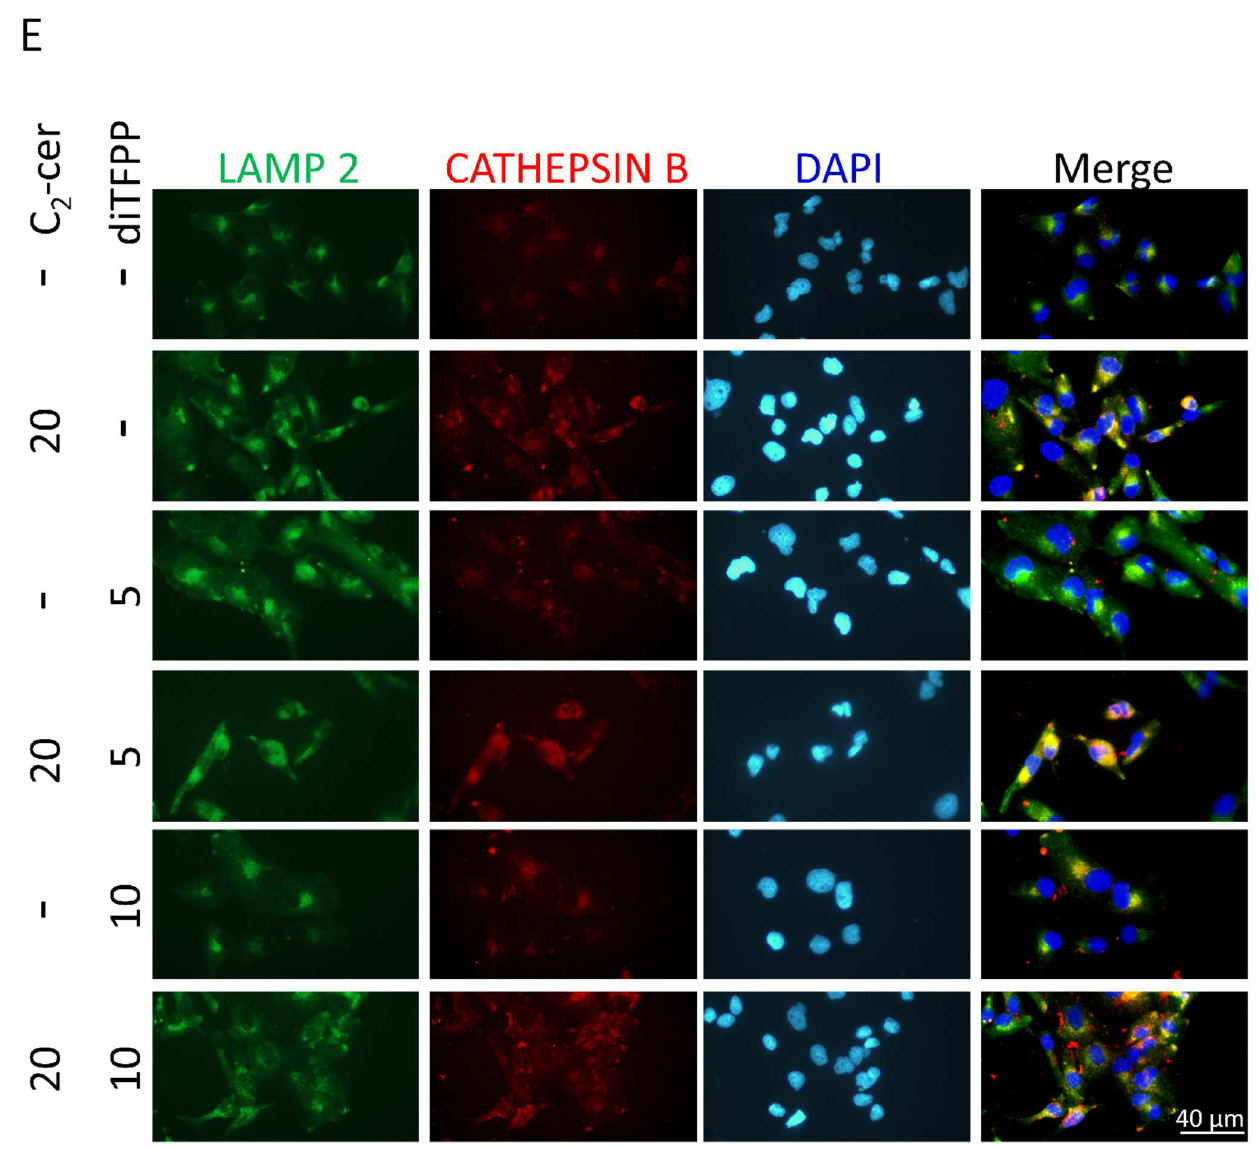
Figure 5. Changes in lysosomal pH during autophagy following diTFPP/C 2 -ceramide cotreatment for 24 h. ( A ) Accumulation of lysosomes was detected using LysoTracker fluorescence staining and observed by fluorescence microscopy. ( B ) Quantitative analysis of acidic organelle accumulation using flow cytometry-based LysoTracker fluorescence staining. Red fluorescence indicates lysosomes # p < 0.05 and ## p < 0.01, * p < 0.05 and ** p < 0.01. ( C ) Changes in lysosomal pH were evaluated by staining with a pH-sensitive LysoSensor™ probe. White arrows indicate the fluorescent puncta where the acidic organelles, especially the lysosomes, localize. ( D ) Changes in the levels of lysosome-associated proteins were evaluated using Western blot analysis. ( E ) The subcellular localization and fluorescence intensity of LAMP2 and CATHEPSIN B were evaluated using an immunofluorescence assay. PreMW: prestained protein molecular weight marker (see Section